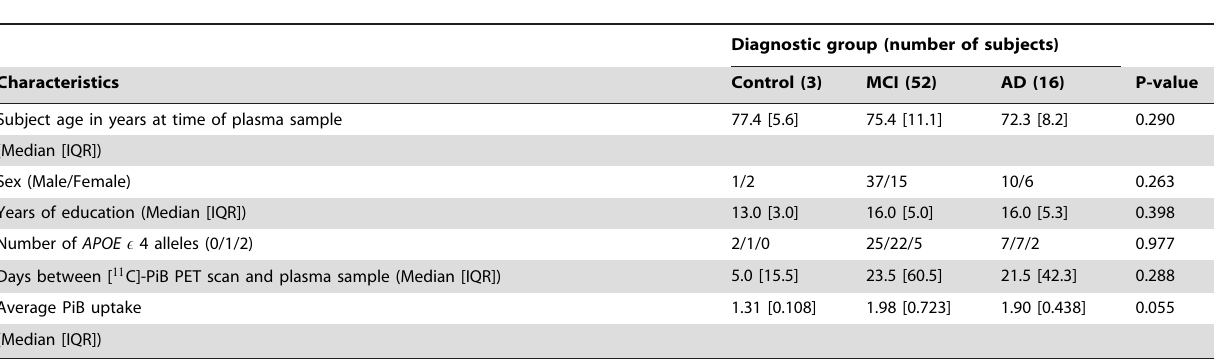
Table 1. Characteristics of the ADNI RBM-PiB PET